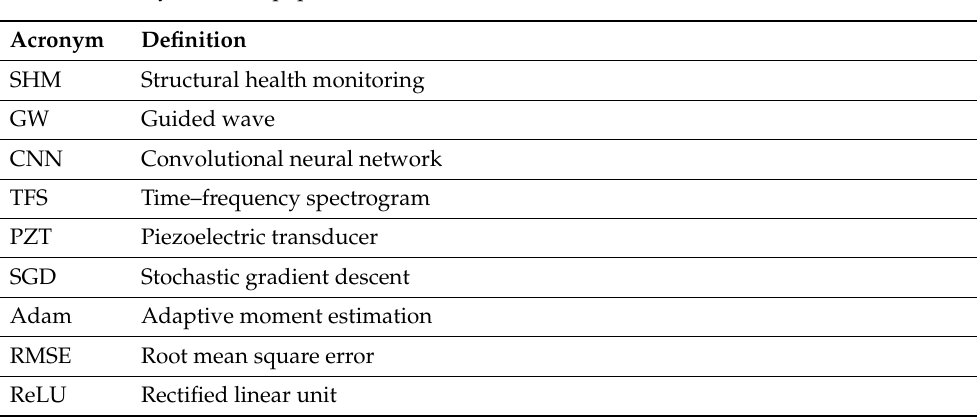
Table A1. Acronyms in this